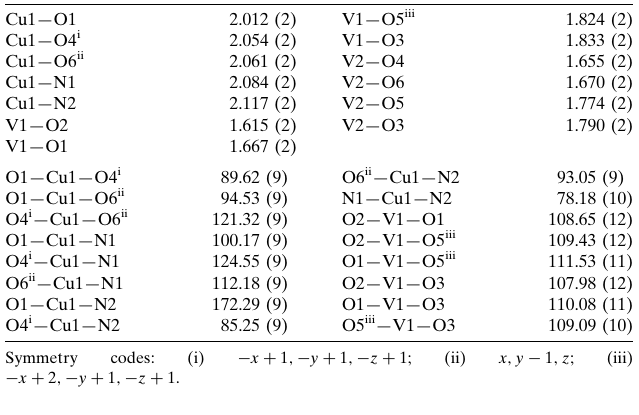
Selected geometric parameters (A˚ , (cid:1)